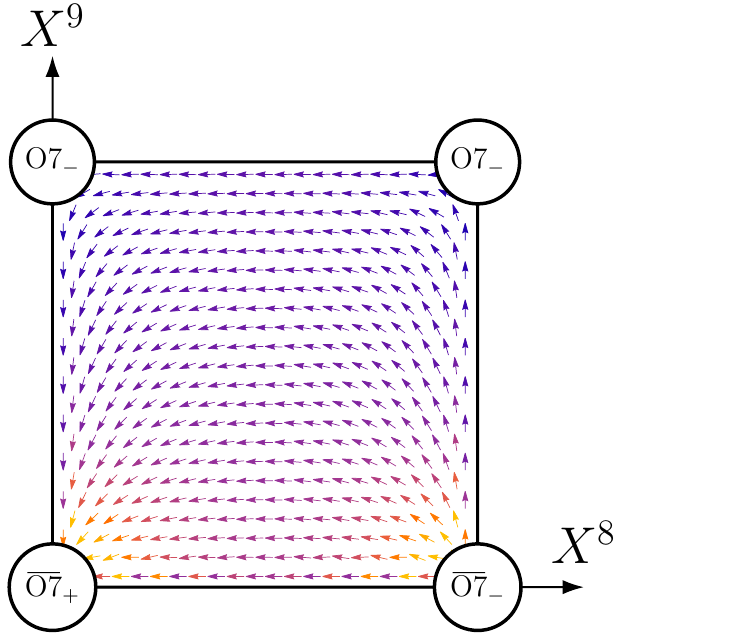
(cid:0) (cid:1) obtained numerically. The lighter the color is, the ∂ V ∂ V , ∂a 8 r ∂a 9 r − −